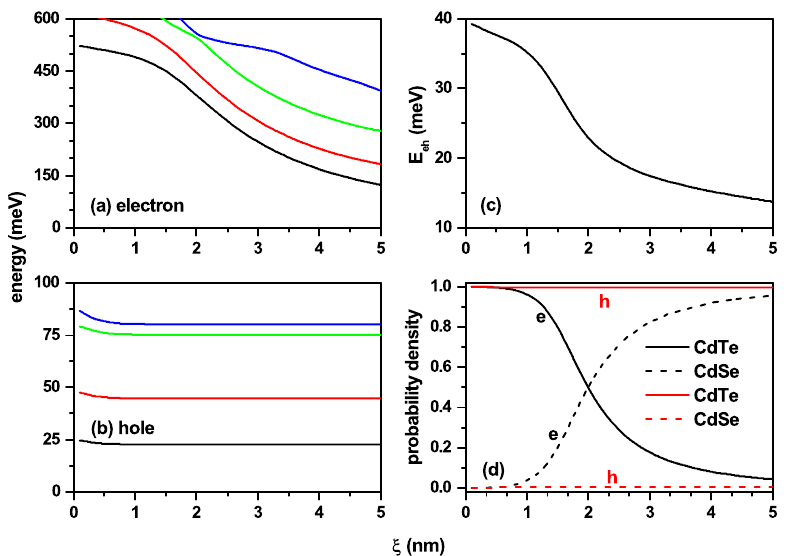
Figure 8. Characterization of the exciton effects in a truncated CdTe–CdSe conical-shaped quantum dot concerning the ξ -parameter. The first fourth energy levels for the electron ( a ) and hole ( b ) are shown. In ( c ), electron–hole Coulomb energy is depicted, whereas in ( d ) are depicted the probability density for both the electron and hole in each material CdTe and CdSe. The calculations are for R 1 = 3 nm, R 2 = 8 nm, h = 12 nm, B = 0, and impurity